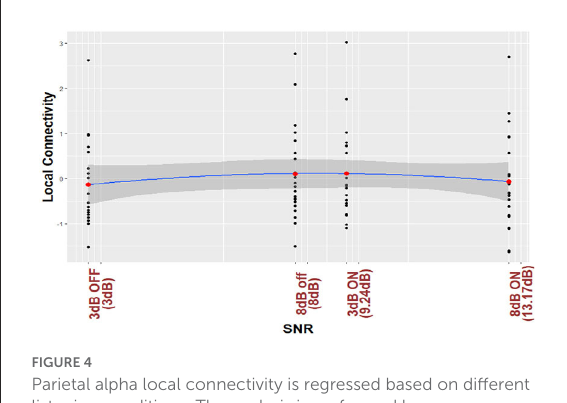
FIGURE4 Parietal alpha local connectivity is regressed based on different listening conditions. The analysis is performed by average over trials data. The black points in the figure show the average over trials for subjects and the red points show the average over black points for different listening